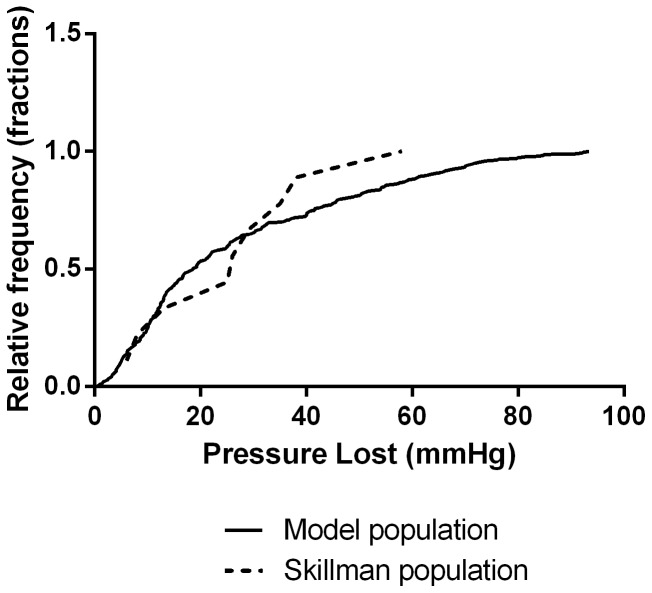
Survival function of the pressure loss experienced by individual models compared with Skillman’s data [5]; the results are similar (p<0.05).The vertical axis denotes the percentage of individuals who lost MAP less than the x-input.